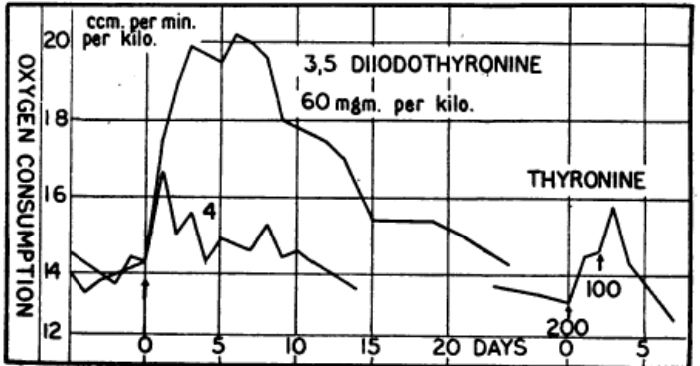
Figure 1 . Effect of 3,5-T2 injection (s.c.) on Oxygen Consumption of Rats: Effect of 3,5-T2 injection (s.c.) on oxygen consumption (ccm/min/kg, normalized to kg body weight) of euthyroid adult male Wistar rats. Compared to T4 (not shown) 15 times higher 3,5-T2 doses elicited the same response, an observation similar to the requirement of 40-fold higher 3,5-T2 concentration compared to T4 needed to induce tadpole metamorphosis (see Gaddum 1927). Thyronine (T0) was inactive in rats after two injections of 200 and 100 mg/kg (lower right), as were diiodotyrosine (DIT) and thyroxamine (T4-Amine) (not shown). Reprinted with permission from Ref. [7] , © 1930, John Wiley and Sons.